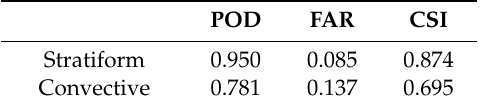
Table 5. Comprehensive evaluation of the KNN classification